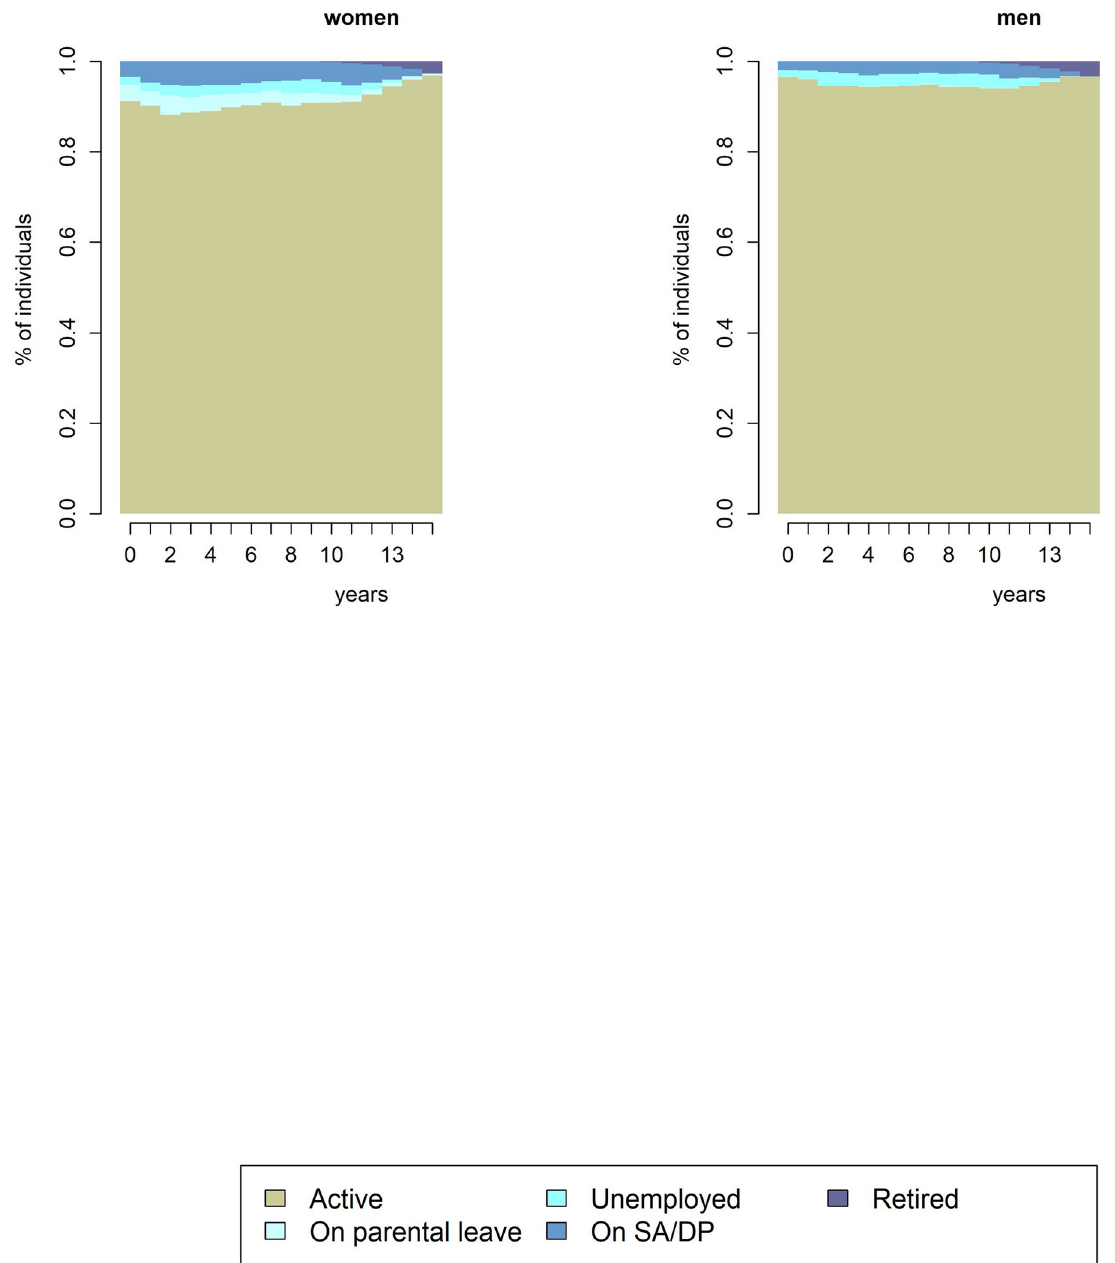
Fig 2. State distribution plots of future yearly working life sequences over a 15-year period, among women and men, respectively.